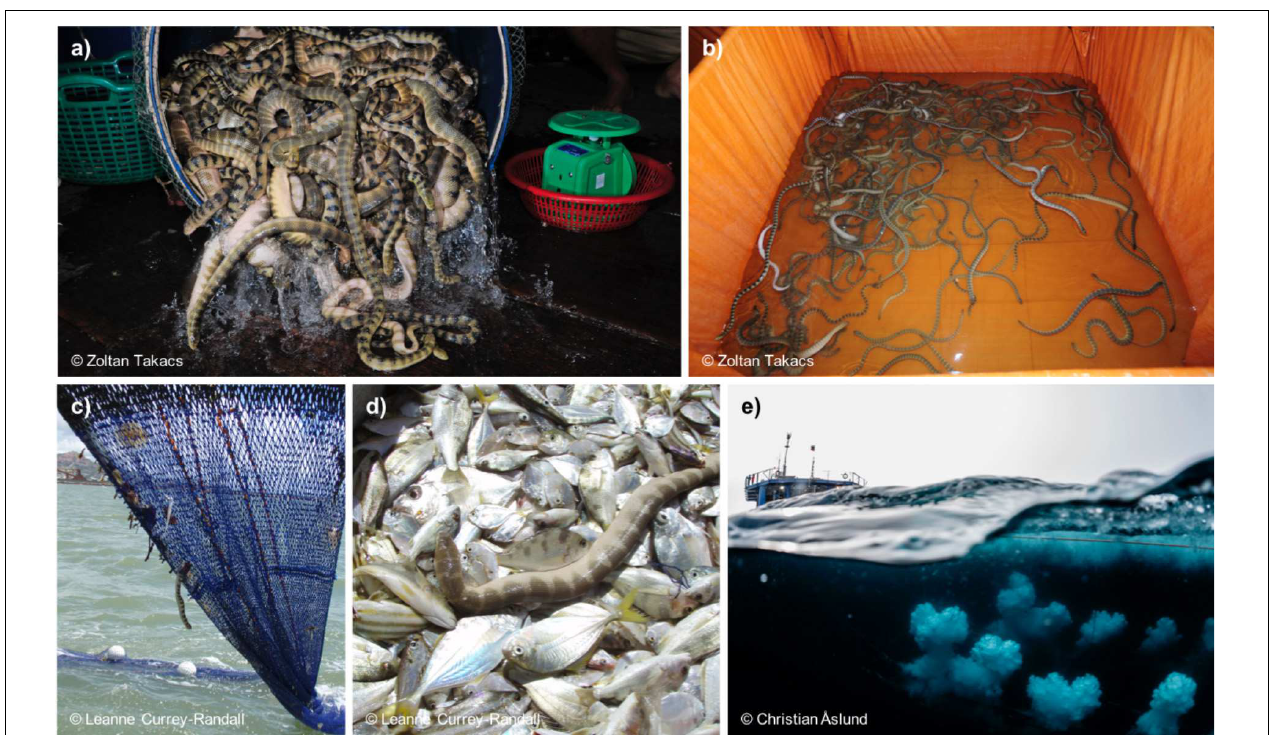
FIGURE 4 | Three known anthropogenic threatening processes on marine snakes; (a,b) targeted harvest of marine snakes in the Gulf of Thailand (Van Cao et al., 2014); (c,d) incidental capture in demersal trawl fisheries; and (e) influence of underwater seismic surveys and associated coastal development from offshore mining activities. Images provided with permission to use from Zoltan Takacs, Leanne Currey-Randall, and Christian